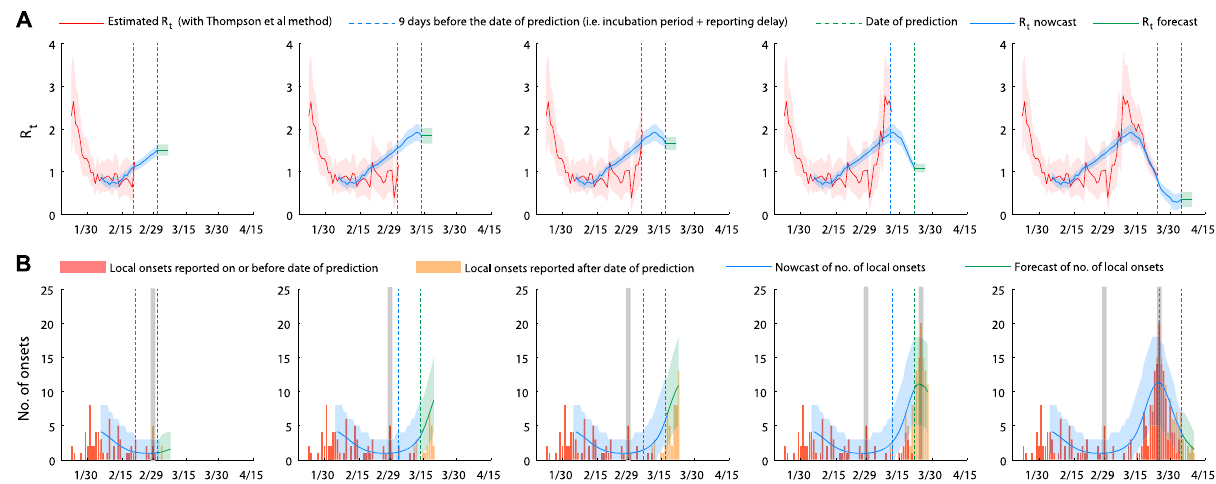
Fig. 3 Retrospective nowcast and forecast of the COVID-19 epidemic in Hong Kong. The green dash lines indicate the dates on which retrospective nowcast, and 6-day forecast were made (2 March, 14 March, 17 March, 22 March, and 4 April). The blue dash lines indicate the latest empirical Rt estimates obtainable from the epidemic curve on those dates. A Comparison between empirical R t estimates and R t from the fi tted SIR model. The red line and shades indicate the empirical R t estimates (posterior mean and 95% credible intervals). Blue lines and shades indicate the nowcasted R t (posterior mean and 95% CrIs). Green lines and shades correspond to the assumption that population mixing (and hence R t ) would remain at status quo for the next 6 days (posterior mean and 95% CrIs). B Nowcast and forecast of local epidemic curves by dates of symptom onset. Red bars showed the number of local onsets reported on or before the date of prediction. Orange bars showed the number of local onsets reported after the date of prediction. Blue lines and